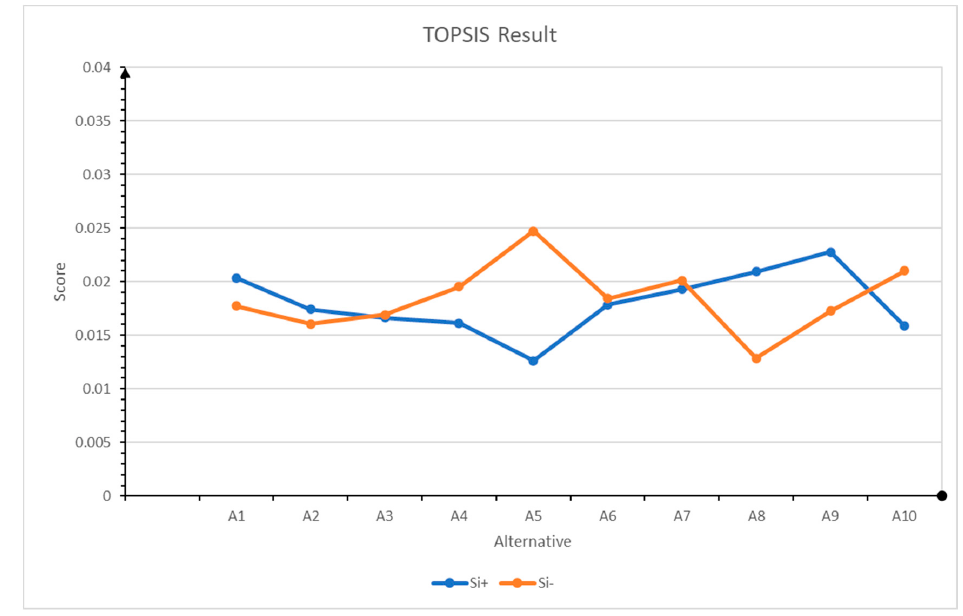
Figure 6. PIS and NIS values.